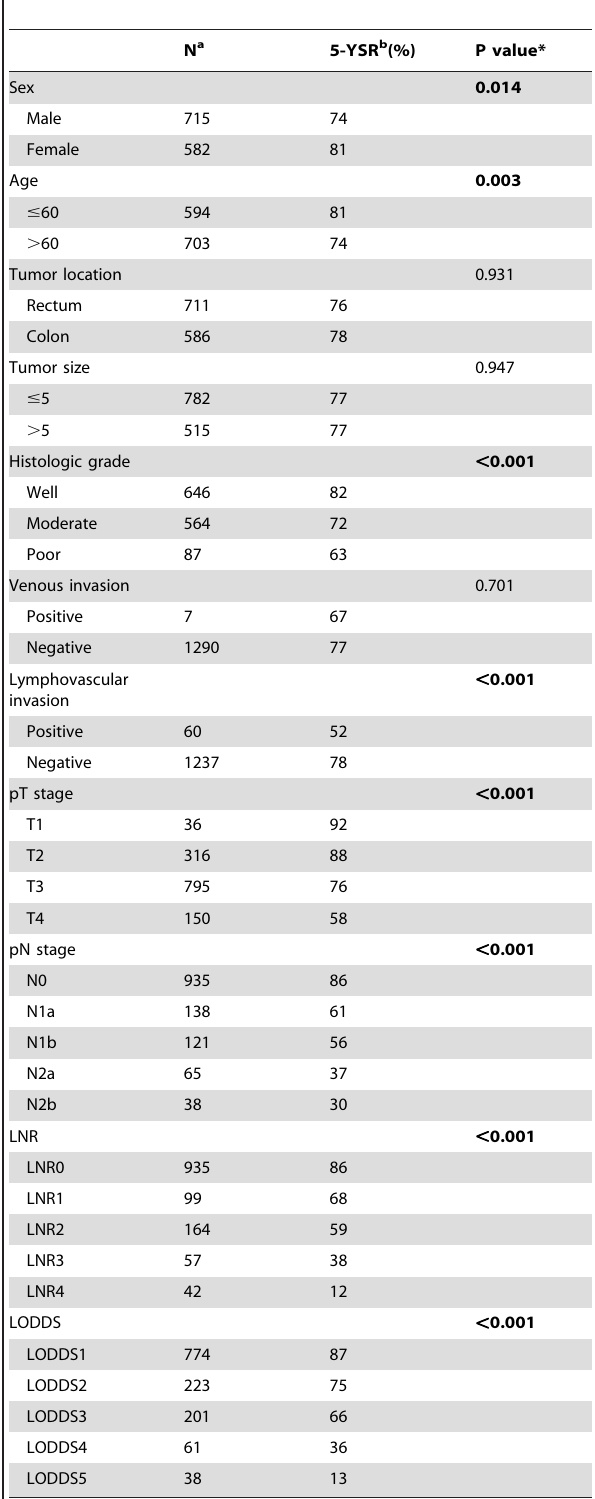
Table 1. Univariate analysis of the prognostic factors for patients with colorectal